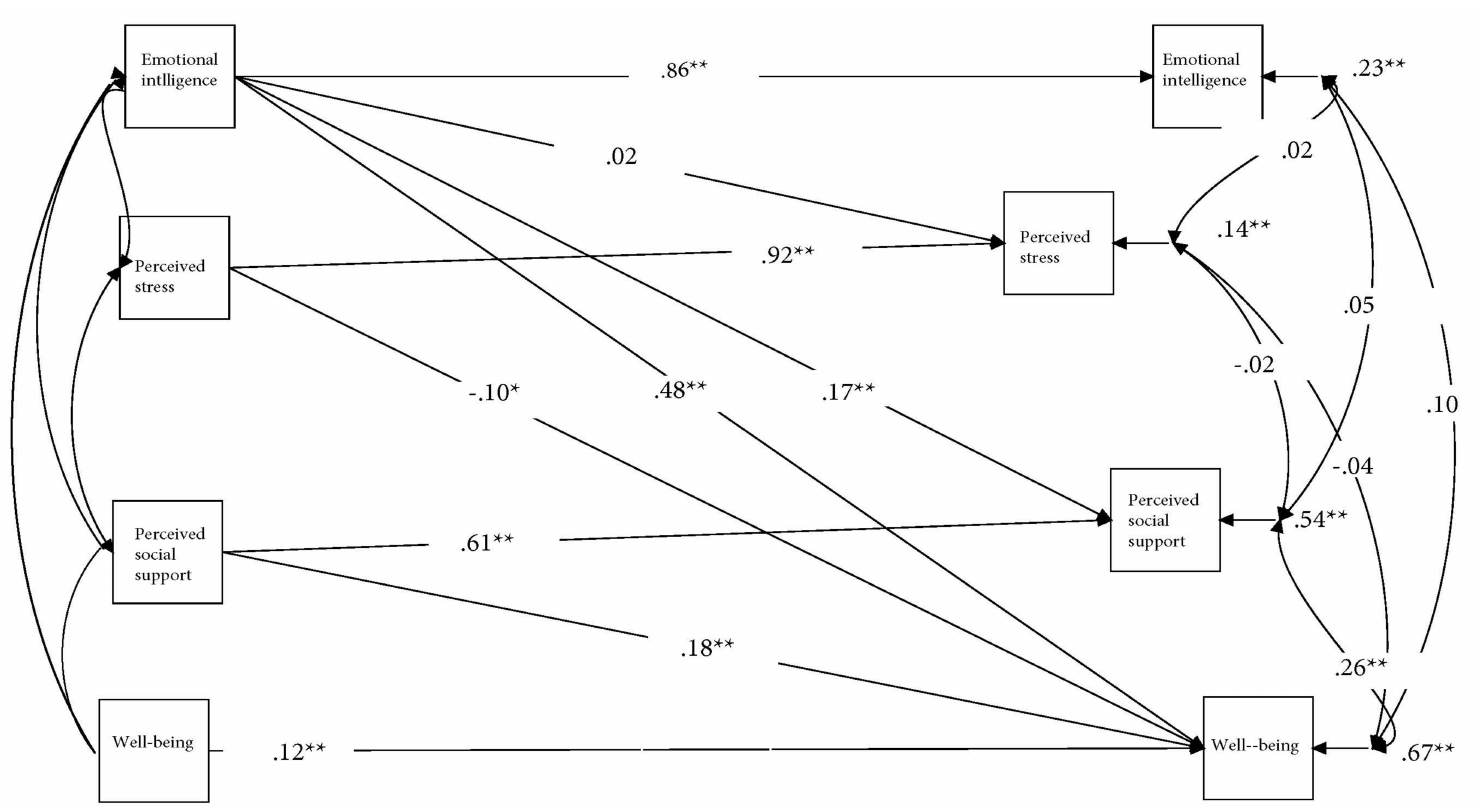
Figure 3. Pathways to mediators and dependent variables. Notes: Values shown are standardized parameter estimates. * p < 0.05; ** p <